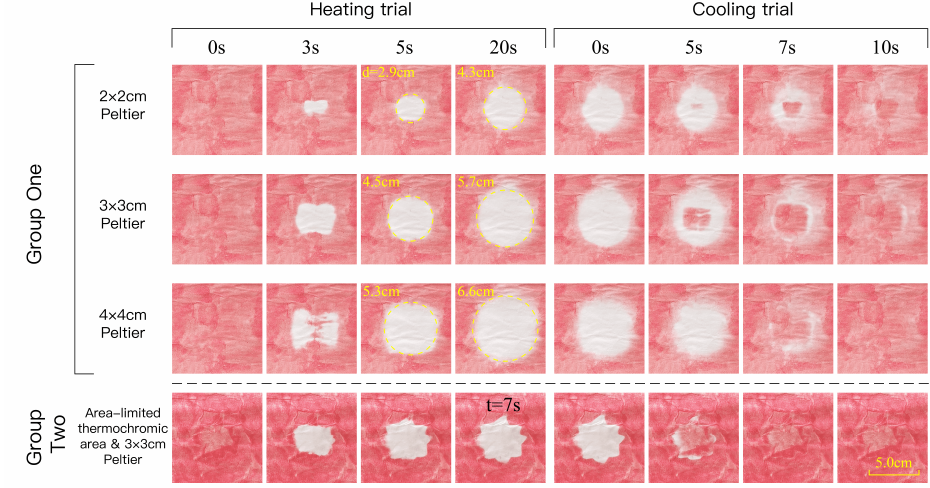
Figure 9. Captures of the color-changing videos of the thermochromic test